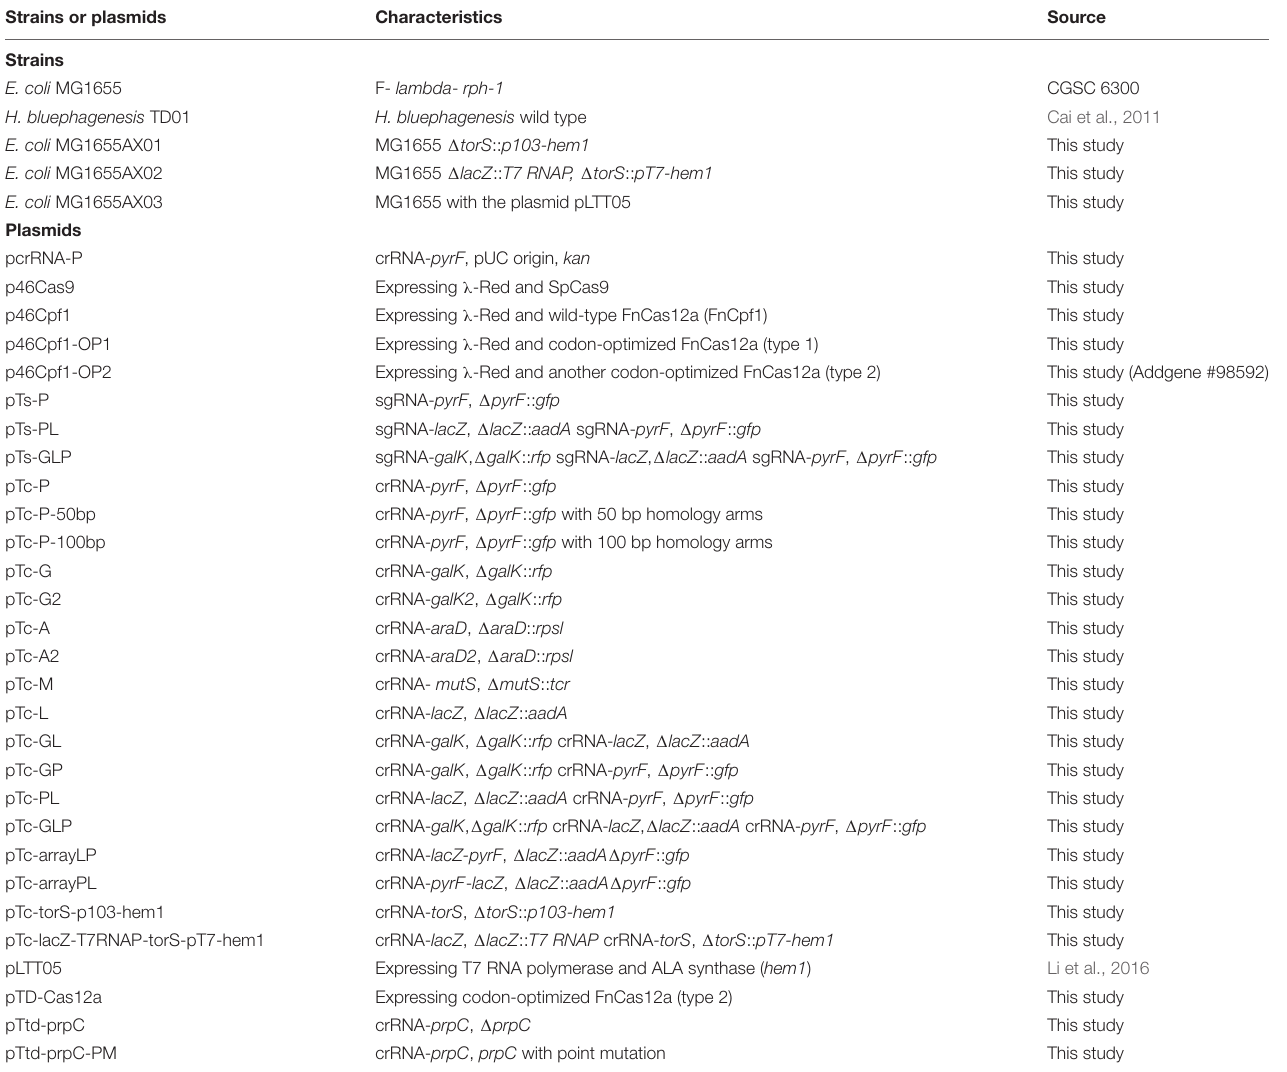
TABLE 1 | Bacterial strains and plasmids used in this study. Strains or